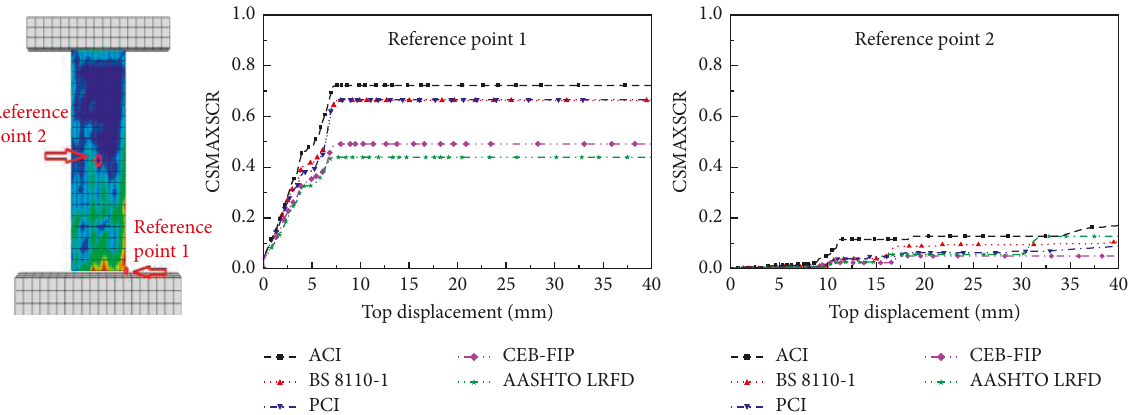
Figure 17: CSMAXSCR-top displacement curves of W2.